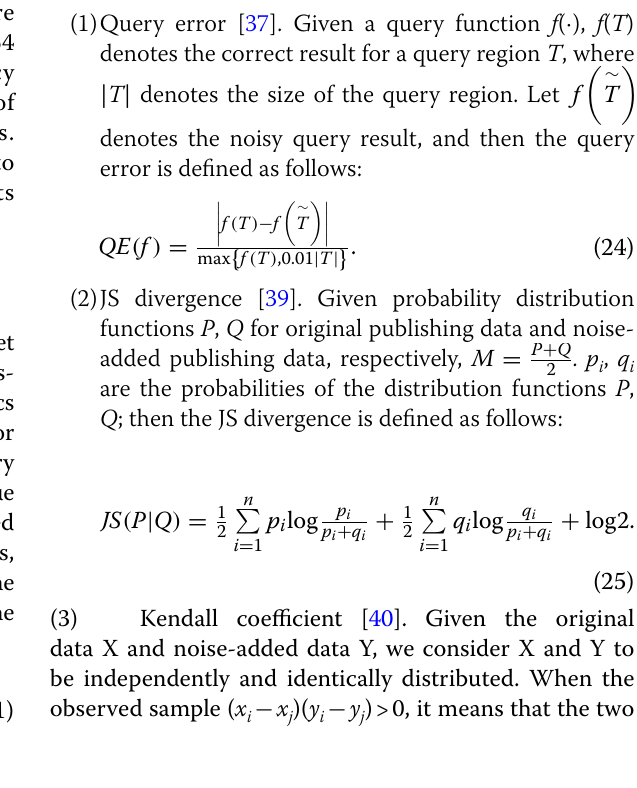
Table 1 Dataset description